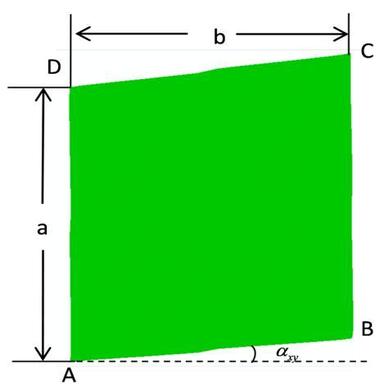
The expression of shear strain at the shear area.